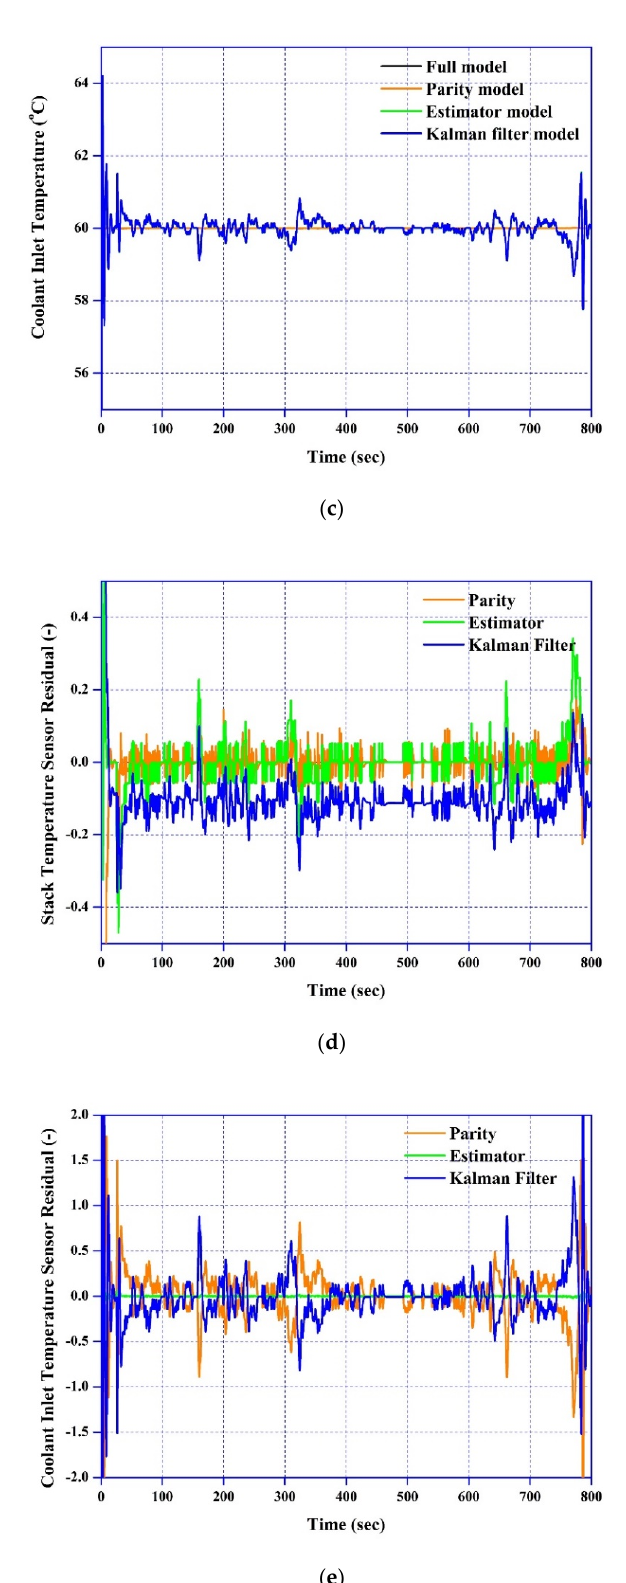
Figure 6. Highway Fuel Economy Test (HWFET) test results in normal condition. (( a )—Current density profiles, ( b )—Stack temperature variation, ( c )—Coolant inlet temperature variation, ( d )—Stack temperature sensor residual, ( e )—Coolant inlet temperature sensor